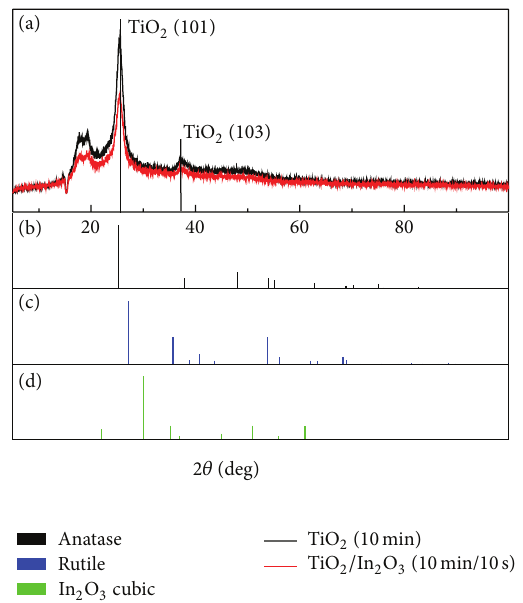
Figure 11: XRD diffraction data for (1) TiO 2 sputtered for 10 min on polyester and (2) TiO 2 10min /In 2 O 3 10s sputtered on polyester: (a) diffraction patterns of anatase (b), rutile (c), and (d) cubic In 2 O 3